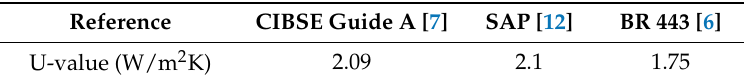
Table 2. Comparison of referenced U-values for solid walls.